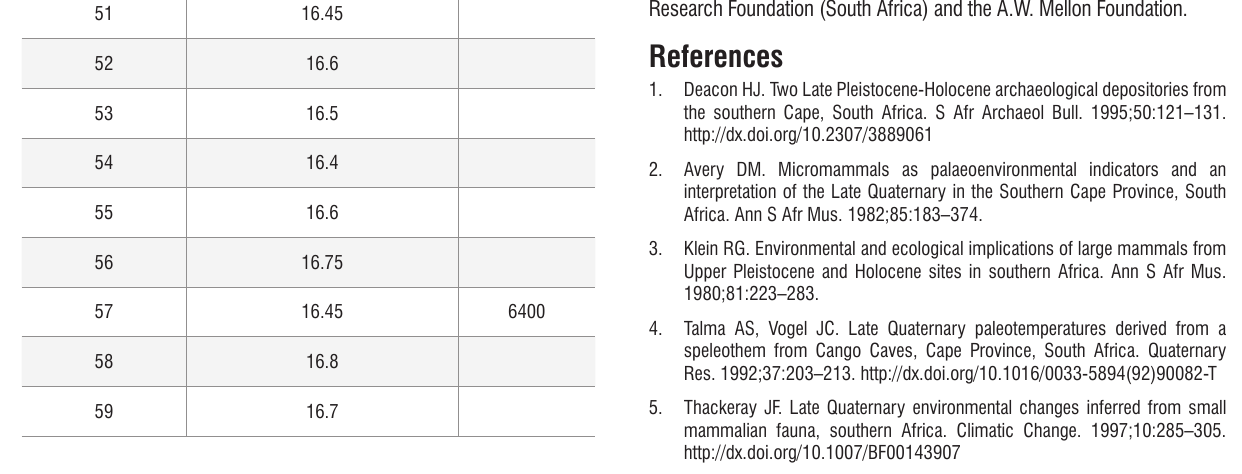
Boomplaas sample Figure 1. Margaret Avery identified the rodents and insectivores from excavations at Boomplaas, directed by Hilary Deacon. The correlations presented are the result of ongoing research on palaeoclimates and faunal analyses, supported by grants awarded to J.F. Thackeray from the National Research Foundation (South Africa) and the A.W. Mellon